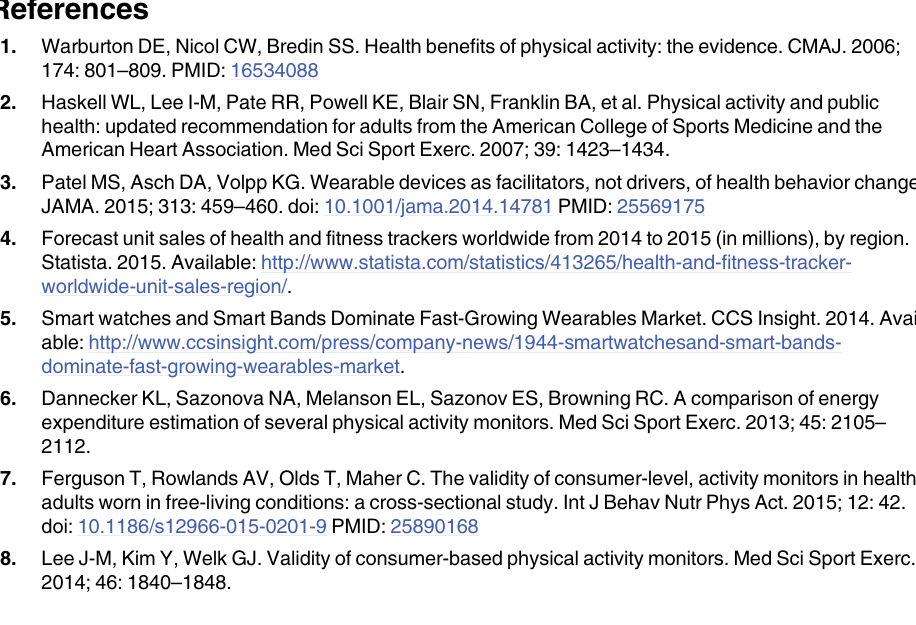
Fig 5. Bland-Altman plots for device [(A) Apple Watch; N = 21, (B) Fitbit Charge HR; N = 21, (C) Samsung Gear S; N = 20] and direct observation (reference) steps. The solid line represents the mean difference (steps) between the two measures and the dashed lines are the 95% limits of agreement (steps). Notes : LoA = limits of agreement, MD = mean